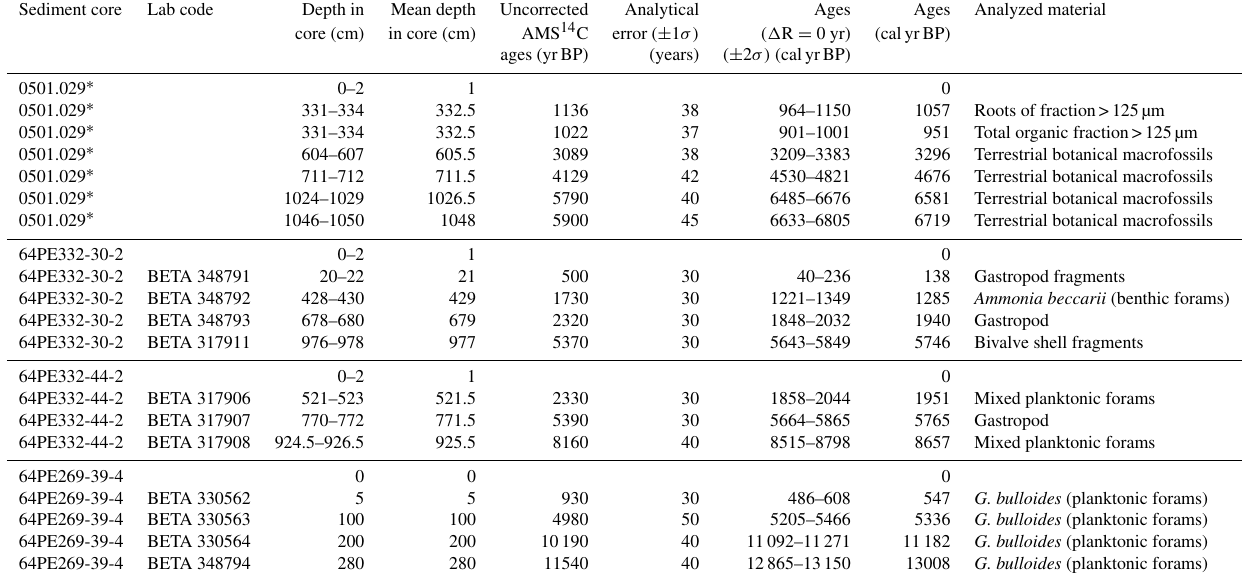
Table 2. Summary of the data used to determine an age depth model for the sediment samples in this study. Sediment core Lab code Depth in Mean depth Uncorrected Analytical Ages Ages Analyzed material core (cm) in core